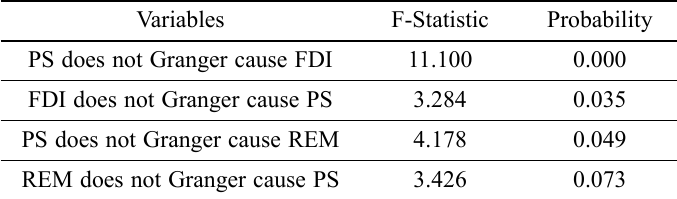
Table 7. Results of Granger causality test